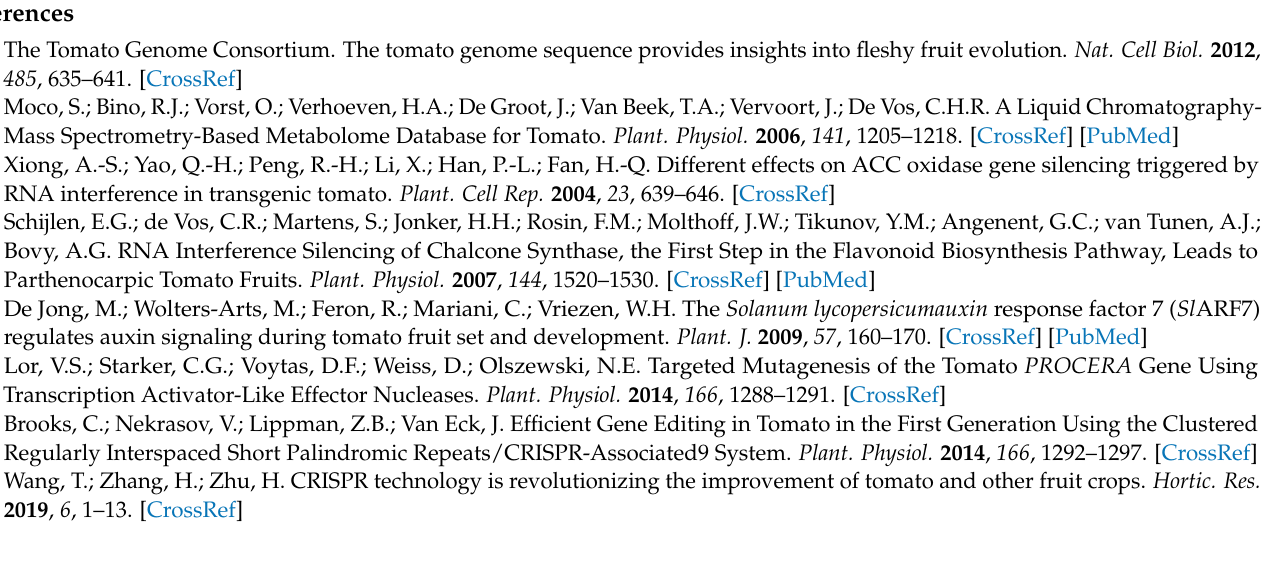
Table S4: Overview of the mlo -mutants described in the